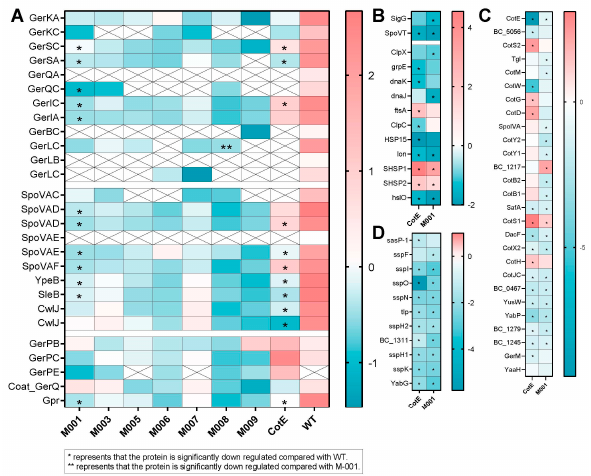
Figure 5. The heatmap of proteins associated with spore germination in spores of various strains ( A ). Color represents z-score of LFQ values; a cross means not detected. The log2 (fold changes) of SASPs ( D ), coat proteins ( C ) and heat shock proteins ( B ) are shown in a colored heatmap. Red represents elevated protein abundance and blue represents decreased LFQ intensities compared to WT spores.